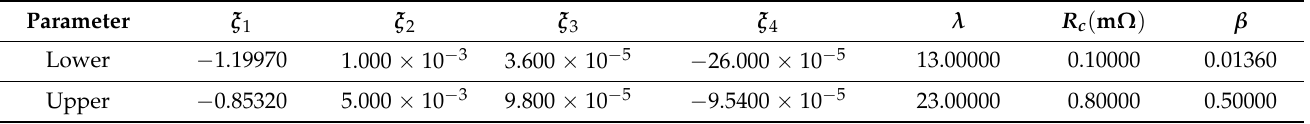
Table 1. Limits of estimated parameters of PEMFC model.